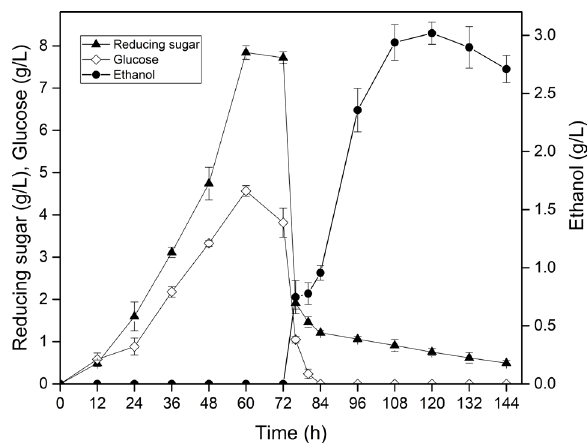
Figure 2: Ethanol production from cellulose by consortium of T. reesei and C. molischiana . T. reesei was initially grown at 30°C and the temperature was risen to 50°C after 36 h. After 72h, the temperature was again lowered to 30°C, and C. molischiana was